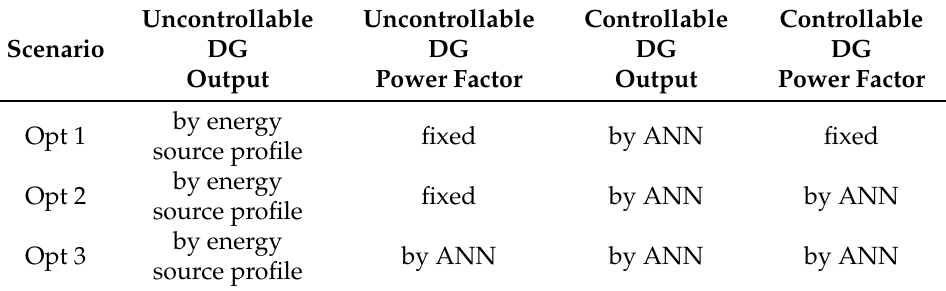
Table 1. The different optimization